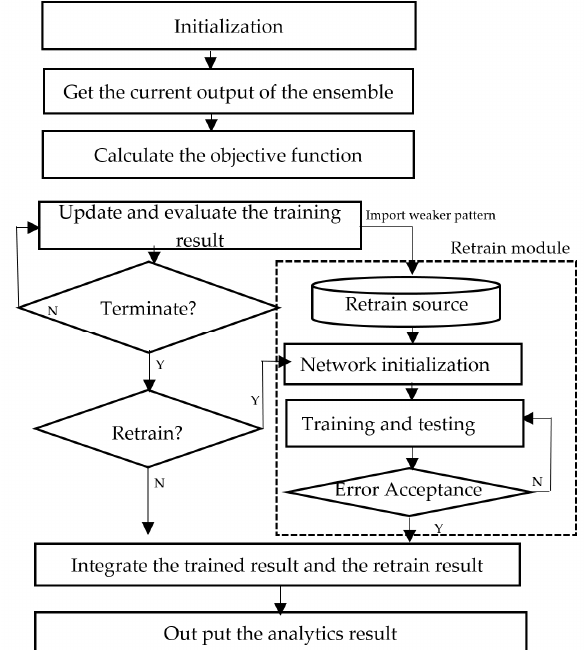
Figure 4. Procedure of the proposed